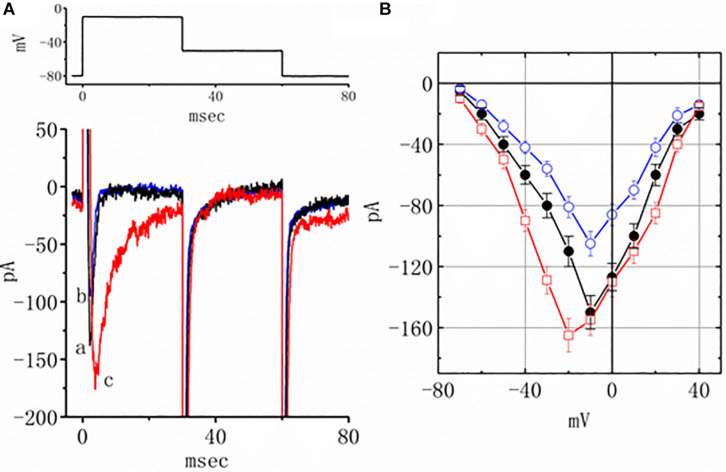
Effects of pioglitazone and pioglitazone plus telmisartan (TEL) on INa in mHippoE-14 neurons. (A) Original current traces attained in the control, pioglitazone, and pioglitazone plus TEL. The upper part indicates the voltage protocol used. a: control; b: pioglitazone (3 μM); c: pioglitazone (3 μM) plus TEL (3 μM). In the experiments with pioglitazone plus TEL, in the continued presence of pioglitazone (3 μM), TEL (3 μM) was subsequently applied. (B)
I–V relationships of peak INa obtained in the control and in presence of pioglitazone and pioglitazone plus TEL (mean ± SEM; n = 7–9 for each point). ⚫: control; ◯: pioglitazone (3 μM); ☐: pioglitazone (3 μM) plus TEL (3 μM).